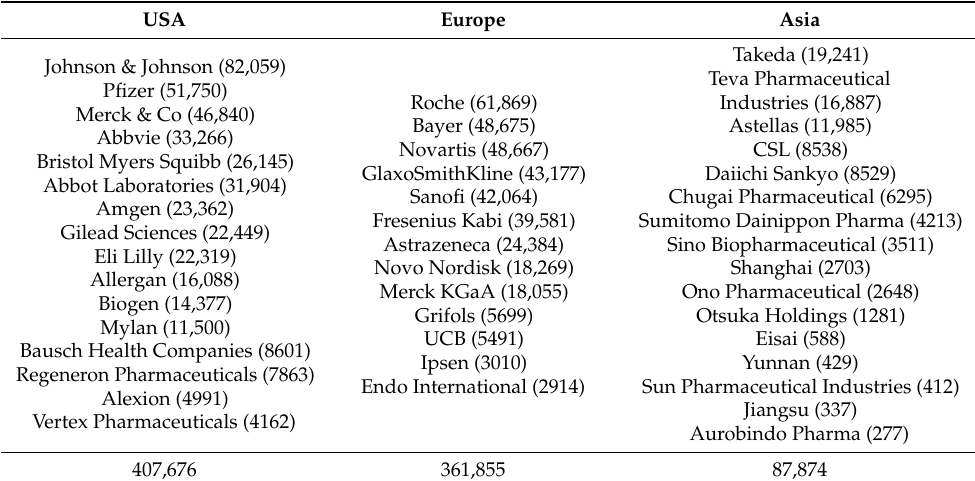
Table 1. The geographic distribution and sales of the 46 analyzed pharmaceutical